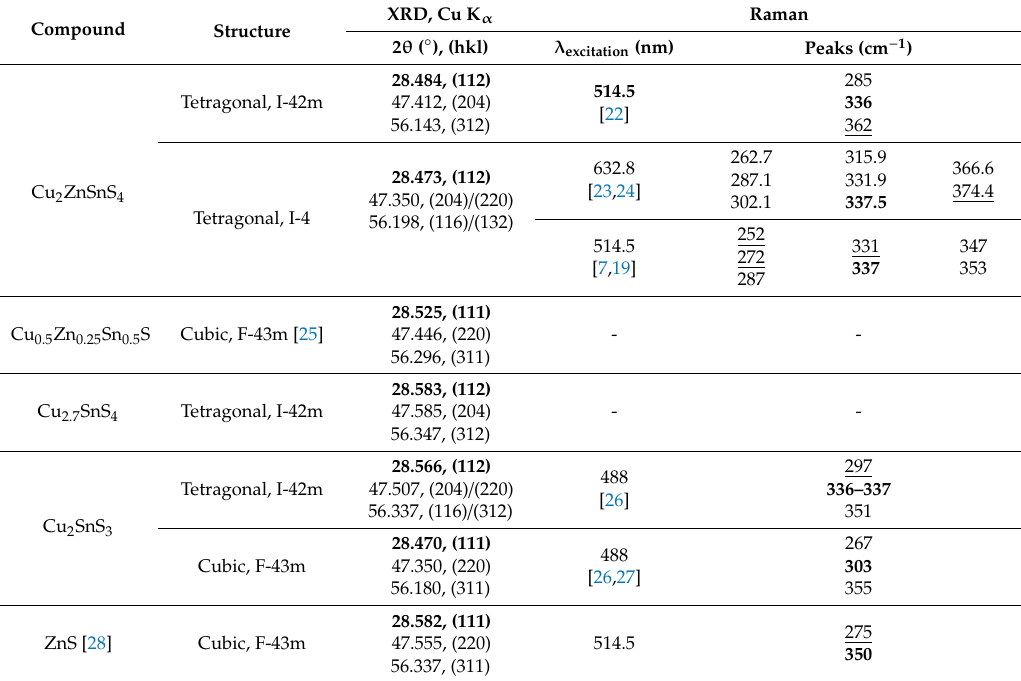
Figure 4. Raman spectra of the combinatorial Cu 2 S–ZnS–SnS 2 samples after sulfurization annealing. The values of Raman peaks obtained by fitting spectra with Lorentzian curves are indicated. Table 4. The wavenumber (in cm − 1 ) of the Raman peaks, from the experimental Raman spectra reported in the literature for the polycrystalline phases, are given in the first column. The XRD 2 θ positions of the most intense peaks, for these phases, and the Raman excitation wavelength are also indicated. The bolded values denote the most intense peaks, while the underlined values are for broad